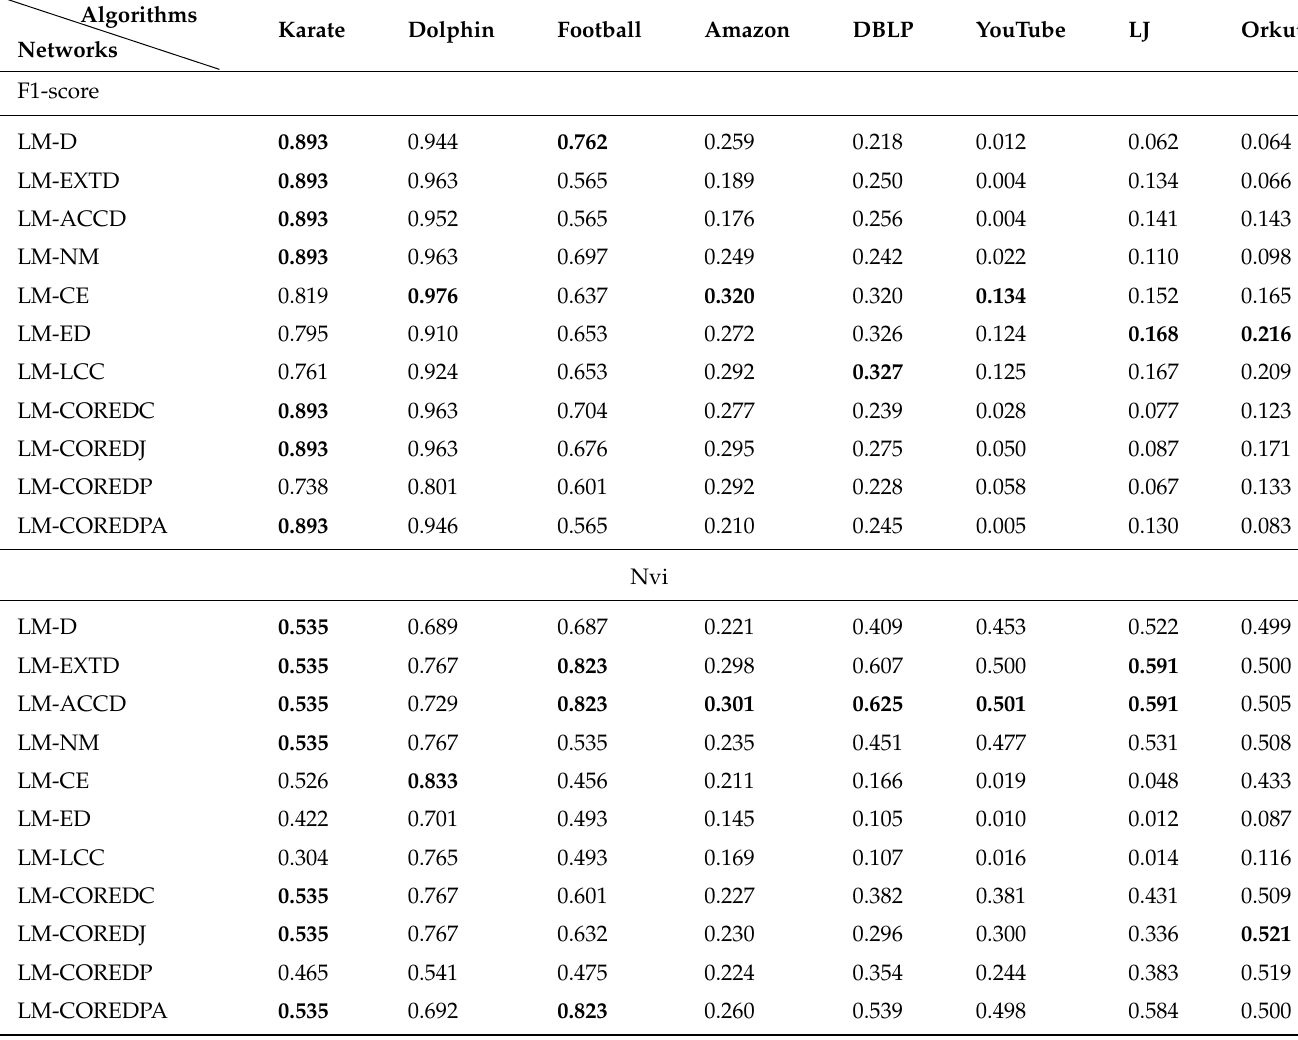
Table 6. The F1-score and Nvi of communities resulting from different local seeding